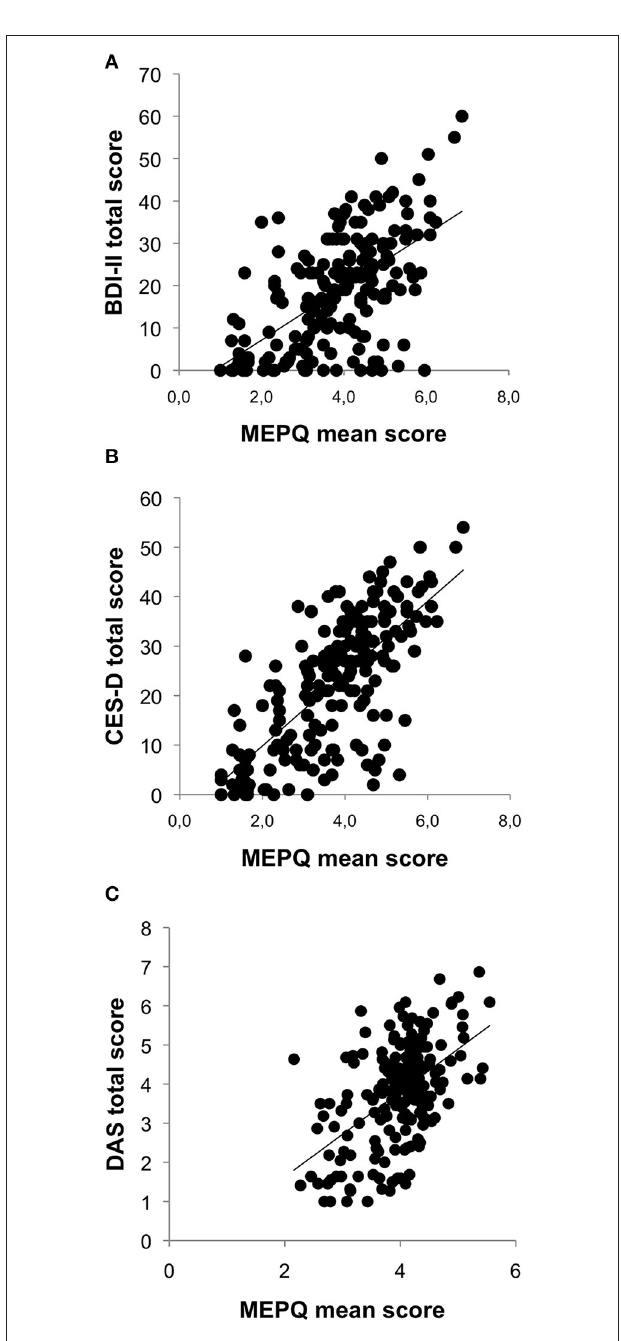
FIGURE 2 | Linear correlation between MEPQ and BDI-II total score (A) , MEPQ and CES-D total score (B), and MEPQ and DAS total score (C)